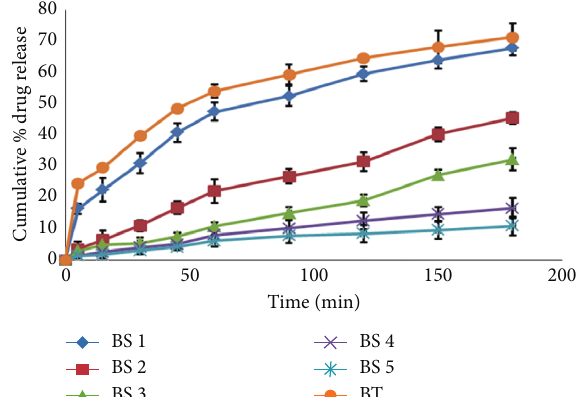
Figure 7: A plot of cumulative percentage alum release with time for suppository formulations BS1, BS2, BS3, BS4, BS5, and BT. (BS: beeswax+ shea butter; BT: theobroma +beeswax). Error bars represent the standard deviation of six replicates.